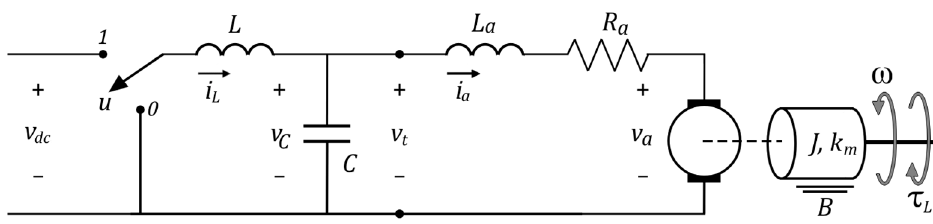
Figure 7. Electrical diagram to regulate the angular speed of the DC motor using the ADRC ap- proach.